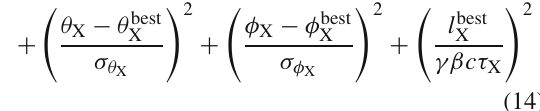
X assumed in the